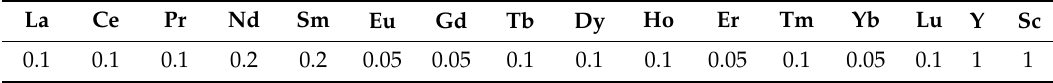
Table 1. The limits of detection (LODs) of the ICP-MS for REEs (mg /